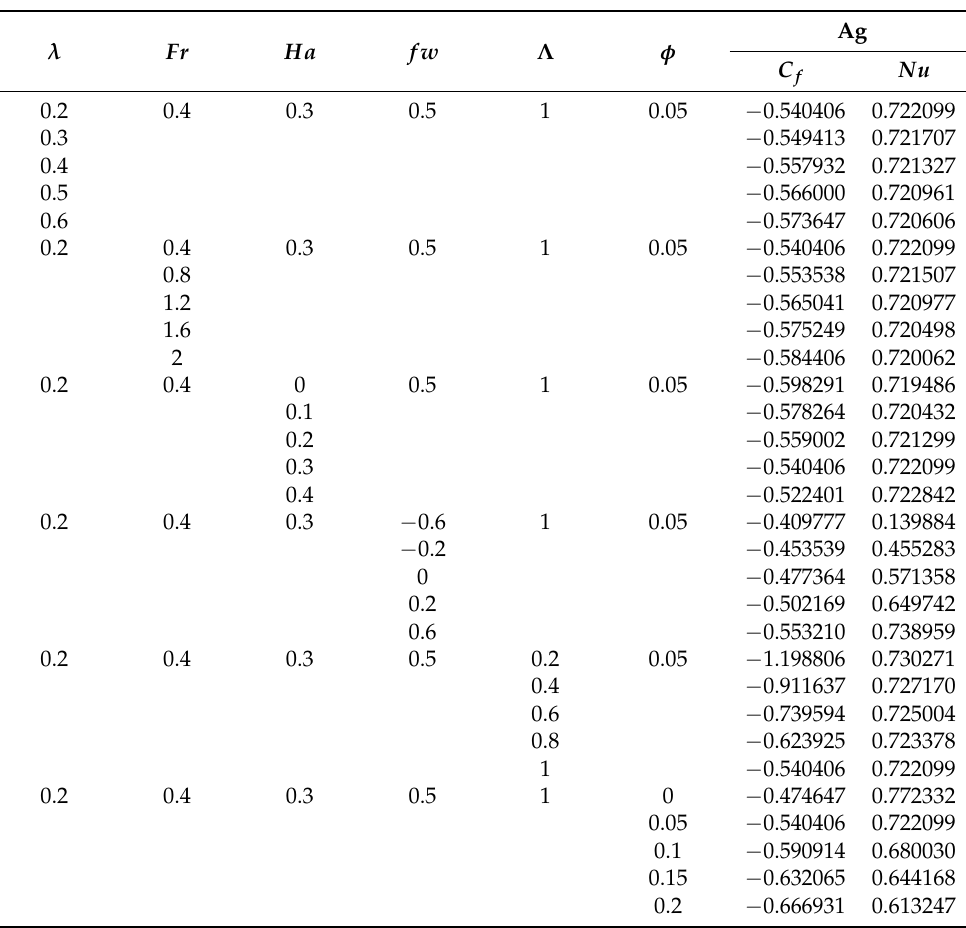
Table 4. SFC & LNN comparison for diverse combo of λ , Fr , Ha , fw , Λ , φ .